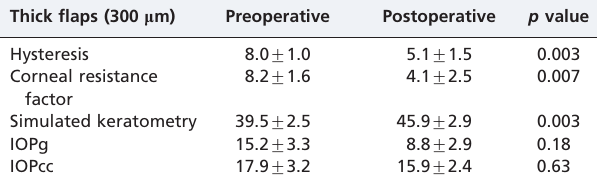
Table 2 - Preoperative and after flap creation ( ¡ SD) hysteresis, corneal resistance factor, simulated keratometry mean, Goldmann-correlated intraocular pressure (IOPg) and corneal-compensated intraocular pressure (IOPcc) for the 300 m m flap group and respective p